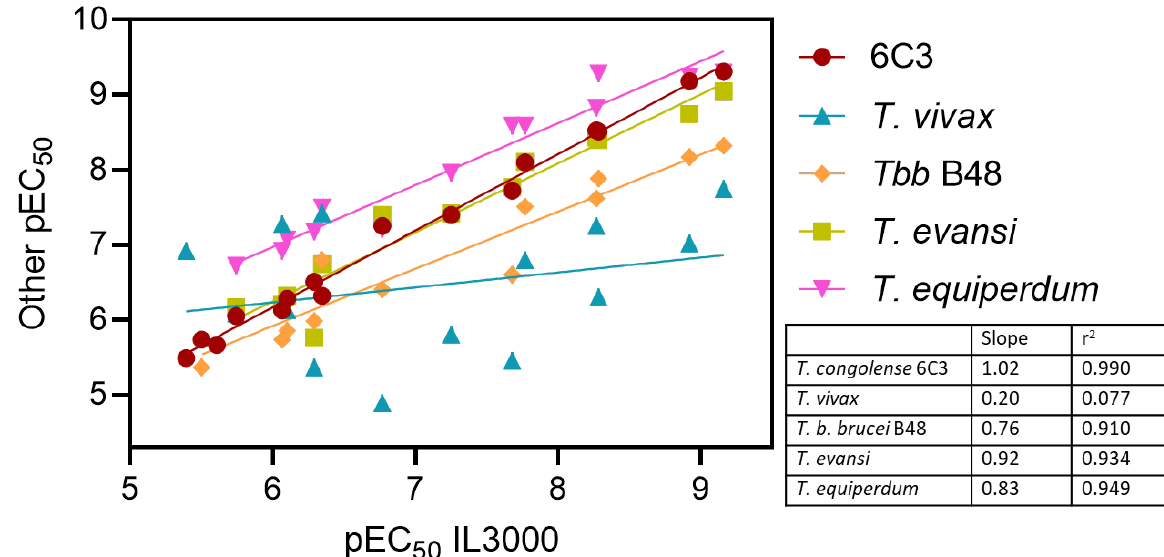
Figure 9. Correlation between the − 10 log(EC 50 ) (pEC 50 ) of adenosine antimetabolites against T. con- golense IL3000 with the pEC 50 for other Trypanosoma cell lines or species. Lines were obtained by linear regression and slopes, correlation coefficients and p value for slope being non-zero were calculated by GraphPad Prism v8.